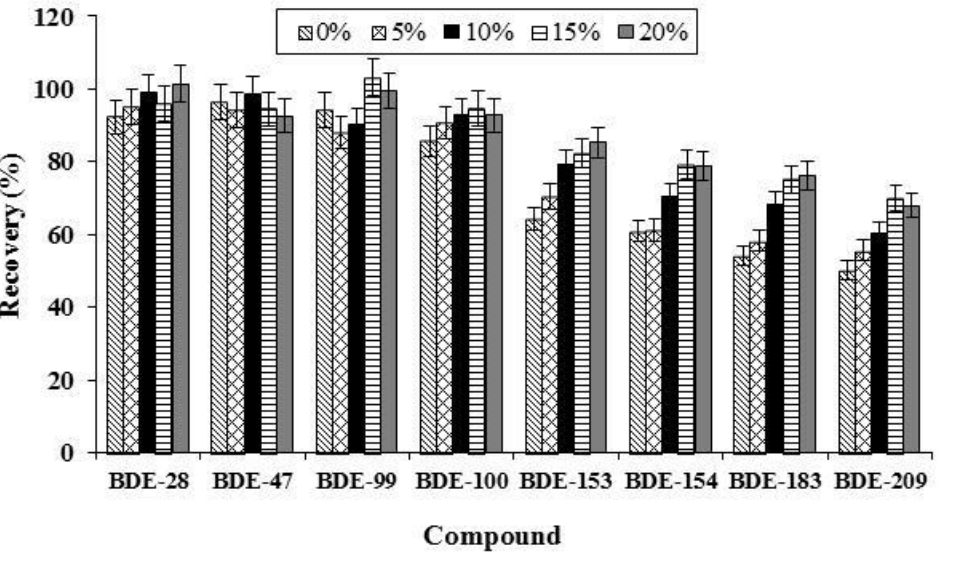
Figure 6. Effect of methanol content on extraction recoveries of eight PBDEs ( n = 3).